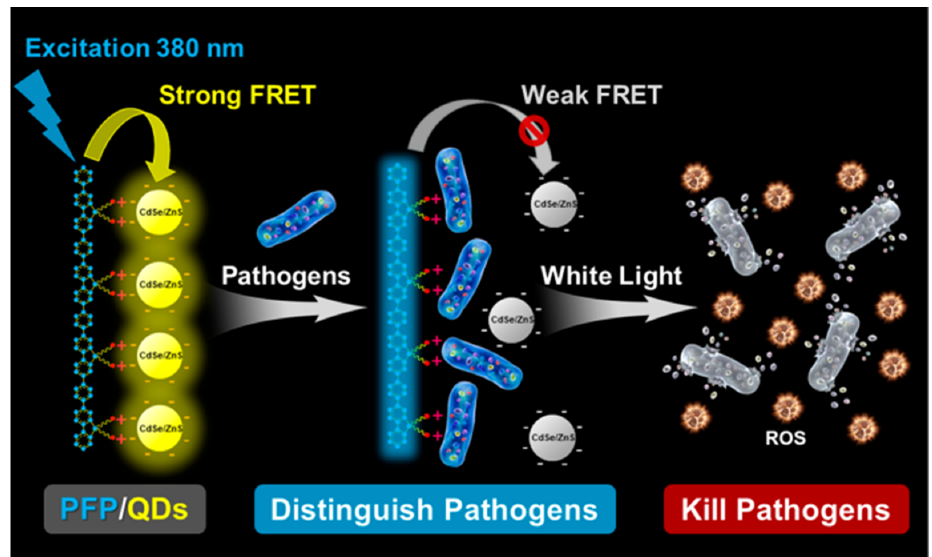
Figure 10. Schematic diagram of PFP/QDs hybrid material for pathogen identification and killing. Reprinted with permission from Ref. [30]. Copyright 2020 American Chemical Society.